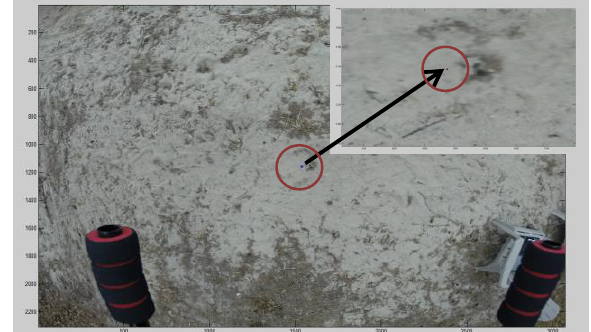
Figure 9. Argus Spectrometer: Dry Sand. Thoth Technology